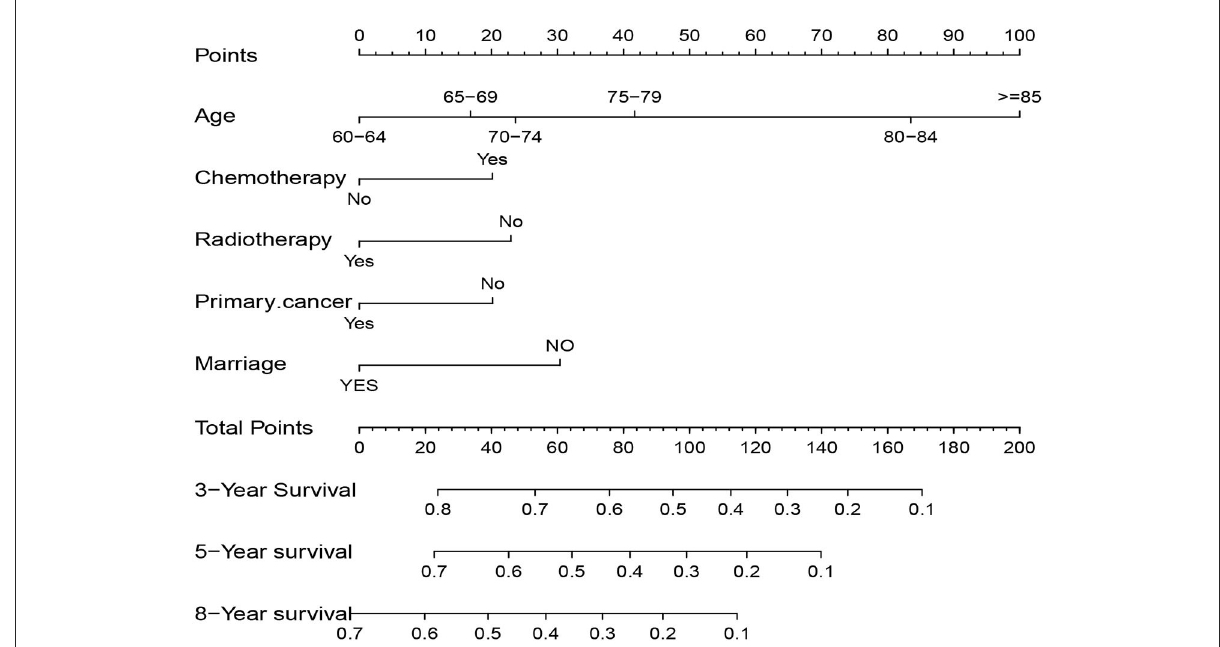
FIGURE2 Nomogram to predict 3, 5, and 8-year overall survival in elderly patients with solitary bone plasmacytoma.